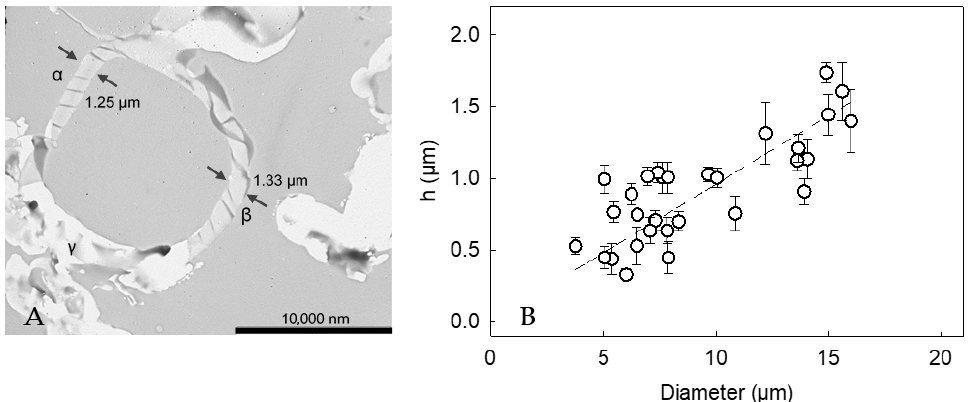
Figure 5. ( A ) Cross-section of a LM-microcapsule (15 µ m) displaying its shell thickness: ( α ) h A = 1.25 ± 0.02 µ m and ( β ) h B = 1.33 ± 0.04 µ m, ( γ ) possible TEM artifacts due to random slicing at planes other than the equator; ( B ) Shell thickness ( h ) versus microcapsule diameter. Linear model performance R 2 = 0.94. Error bars may be smaller than the size of the symbols.